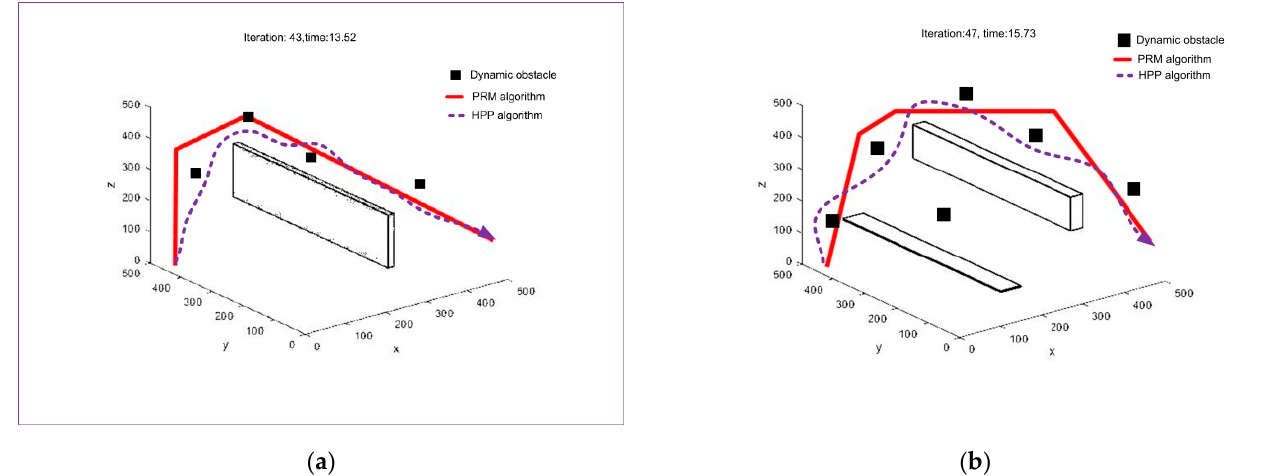
Figure 5. UAV’s path using the proposed HPP algorithm with static and dynamic obstacles: ( a ) with single static obstacle and four dynamic obstacles and ( b ) multiple static obstacles and six dynamic obstacles.